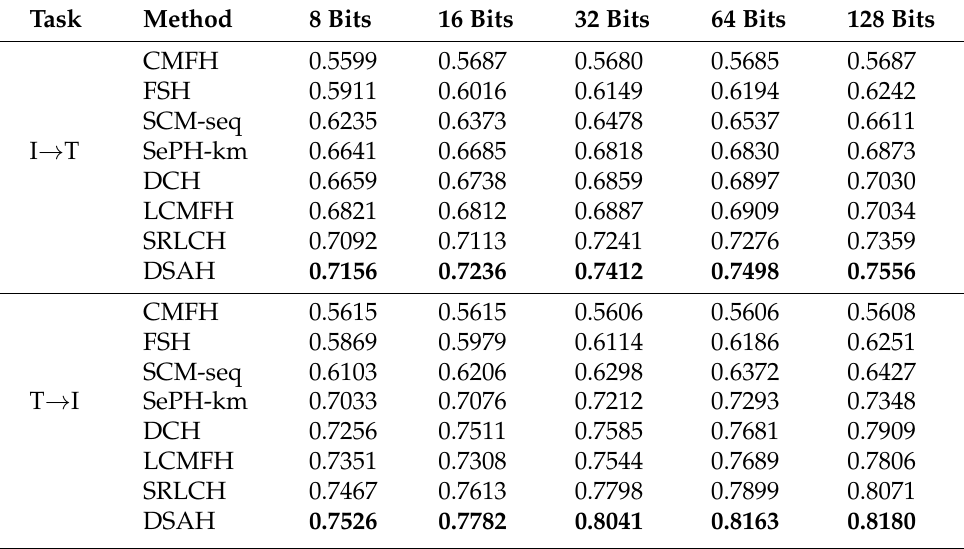
Table 2. Performance comparison on MIRFlickr dataset measured by mAP.